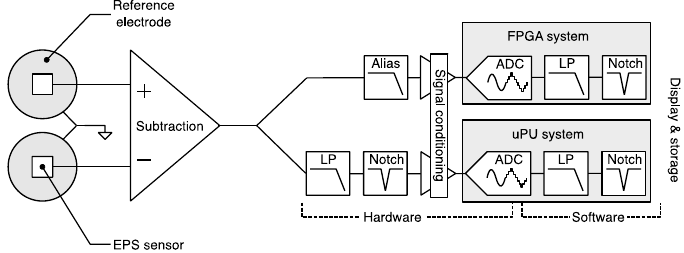
Figure 1. EPS sensor connection and system architecture overviews for FPGA and μ PU